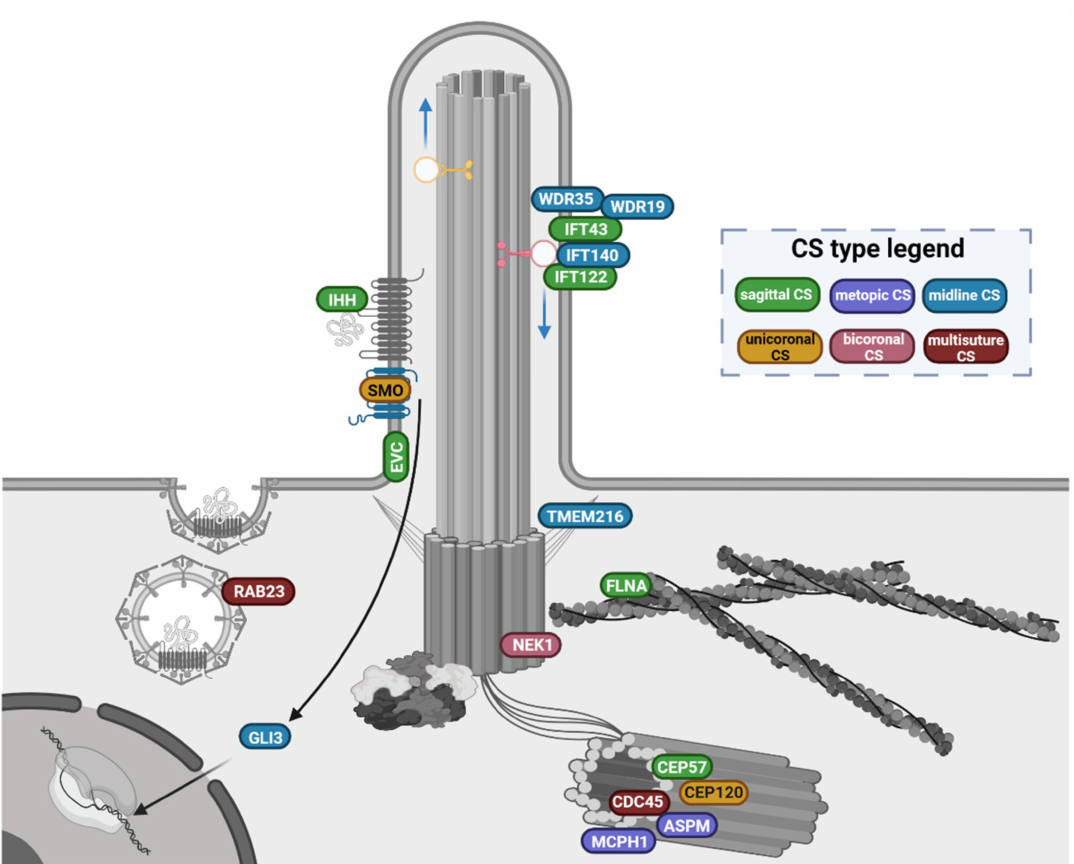
Figure 3. Overview of the primary cilium-related gene products involved in CS pathophysiology. Genes are clustered according to their function and location in the ciliary structures. Gene products labels are coloured after the suture sites (CS type legend) that are prevalently involved in the associated phenotypes (see Sections 3.1 and 3.2 for details). The functional ciliary gene clusters and the associated phenotypes indicate some level of genotype/phenotype correlations: (i). the genes encoding adaptor proteins needed for the intraflagellar complex A-mediated retrograde transport ( IFT122, IFT43, IFT140, WDR35, WDR19 ) are found mutated in phenotypes with midline CS, prevalently affecting the sagittal suture; (ii). genes encoding main players of the hedgehog pathway ( SMO, GLI3, IHH, EVC and RAB23 ) are associated with more heterogeneous suture involvement, ranging from single sagittal or unicoronal CS, to bicoronal and multi-suture craniosynostoses; (iii). the genes products involved in the regulation of centrosome cycle, ciliary trafficking and cilium assembly are mutated in syndromes that may feature either midline CS ( ASPM, MCPH1, CEP57, TMEM216, FLNA ), or uni/bicoronal CS ( NEK1, CEP120 ) up to multisuture CS ( CDC45